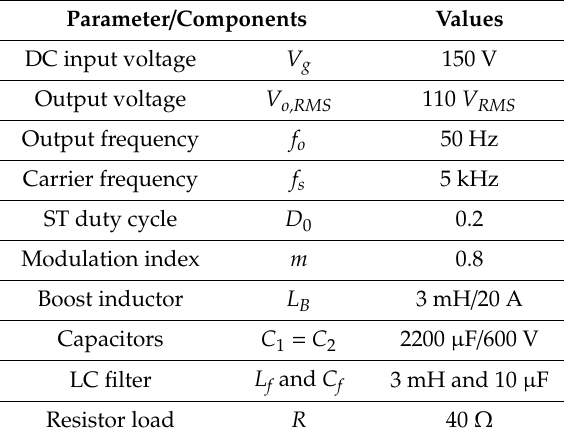
Table 4. Simulation and experiment parameters.